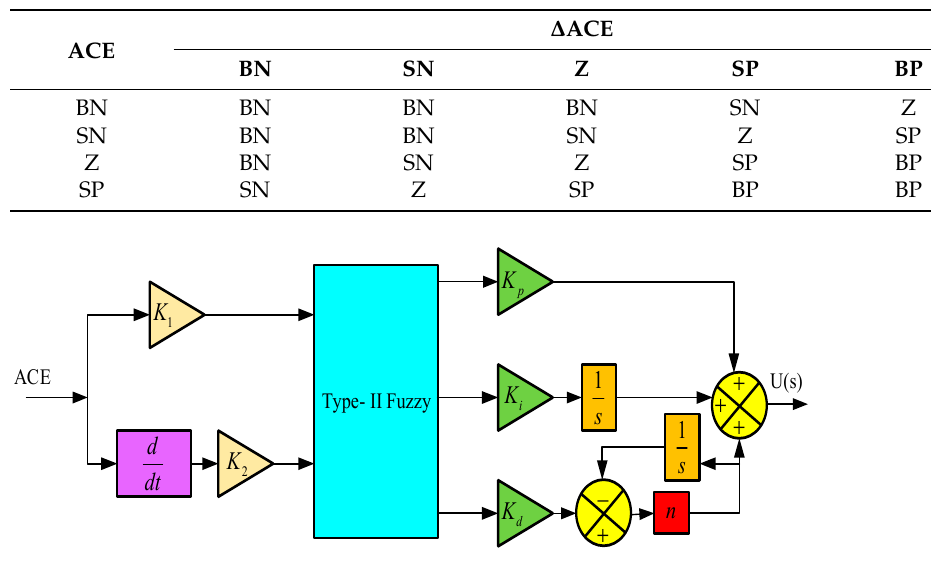
Figure 4. Structure of the T2-FPID controller.